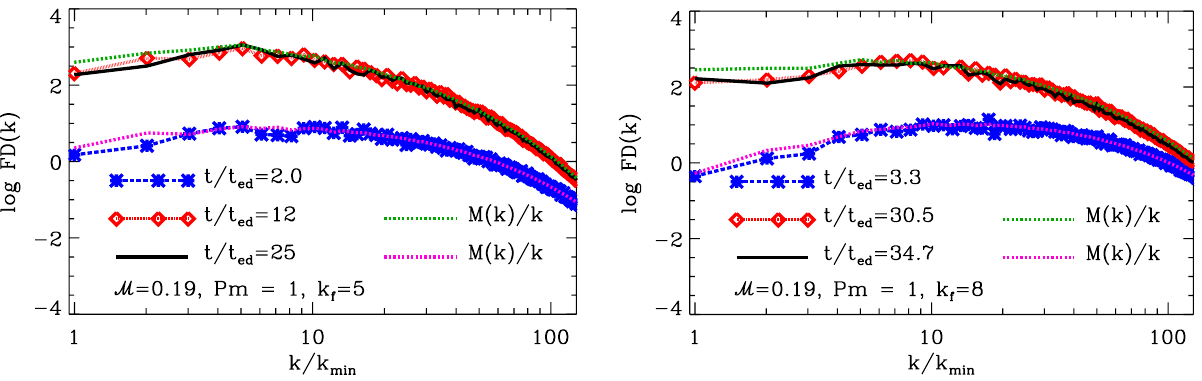
Figure 2. Power spectra of the Faraday depth. The blue dotted curve corresponds to the spectra in the kinematic phase, while the red dashed and black curves correspond the spectra in the saturated phase at two different times. For comparison, the magenta and green dashed curves show the scaled spectra of M ( k ) / k in the kinematic and saturated phases, respectively. The left and right figures correspond to k f = 5 and k f = 8 simulations, respectively. Here, the wave number is normalized in units of k min = 2 π / L